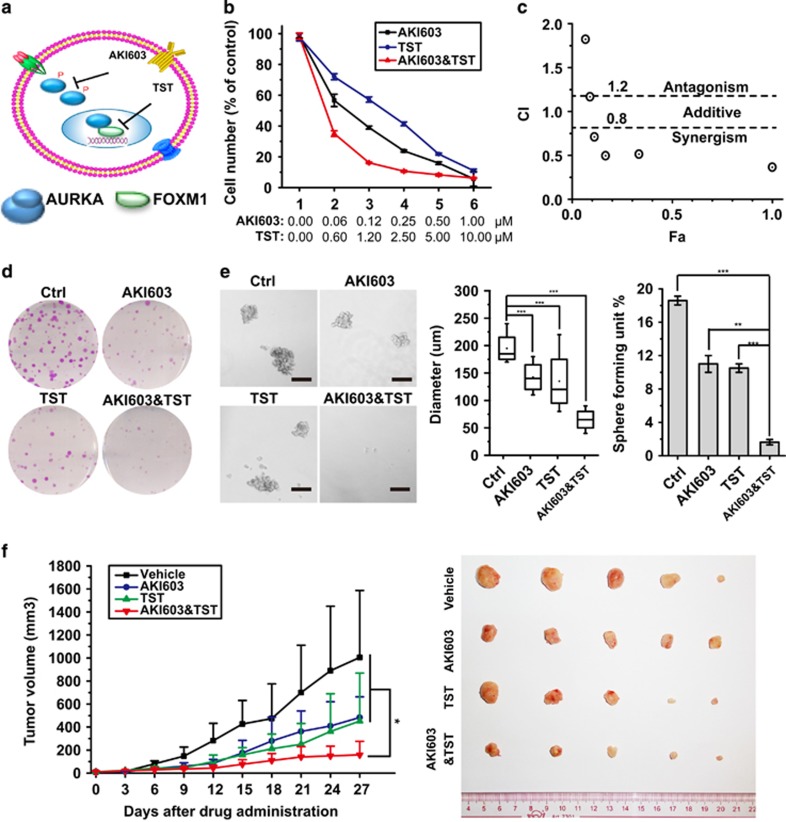
AKI603 and thiostrepton synergistically suppress BCSCs. (a) Scheme depicting the strategy to combine AURKA kinase inhibitor with FOXM1 inhibitor. (b) The cells were treated with various concentrations of drugs alone or in combination for 48 h. The DMSO-treated group proliferated normally. The growth inhibitory effects were determined by cell counting. The Y axis represents percent of viable cell number of drug-treated group versus DMSO-treated group. (c) CI value was calculated from data obtained in b. (d) MDA-MB-231 cells were treated 48 h with 0.12 μM AKI603, 1.2 μM thiostrepton alone, or in combination. Then, 500 cells were seeded into six-well plate and incubated with growth medium containing 0.12 μM AKI603, 1.2 μM thiostrepton alone, or in combination. After culture for 7 days, colonies were stained using crystal violet and the graphs were captured by invert microscope. (e) MDA-MB-231 cells were treated 48 h with 0.12 μM AKI603, 1.2 μM thiostrepton alone, or in combination. Then, 500 cells were seeded into low adhesion six-well plate and incubated with sphere medium containing 0.12 μM AKI603, 1.2 μM thiostrepton alone, or in combination. After culture for 7 days, spheres (diameter >50 μm) were analysed. (f) Nude mice bearing MDA-MB-231 xenograft tumours were treated with AKI603, thiostrepton, or the combinational therapy daily by intragastric administration for 14 days. The tumour volume was measured and calculated as shown. The above assays were repeated at least three times independently and results presented as mean±s.d. **P<0.01; ***P<0.001 significance by Student's t-test (two tailed).